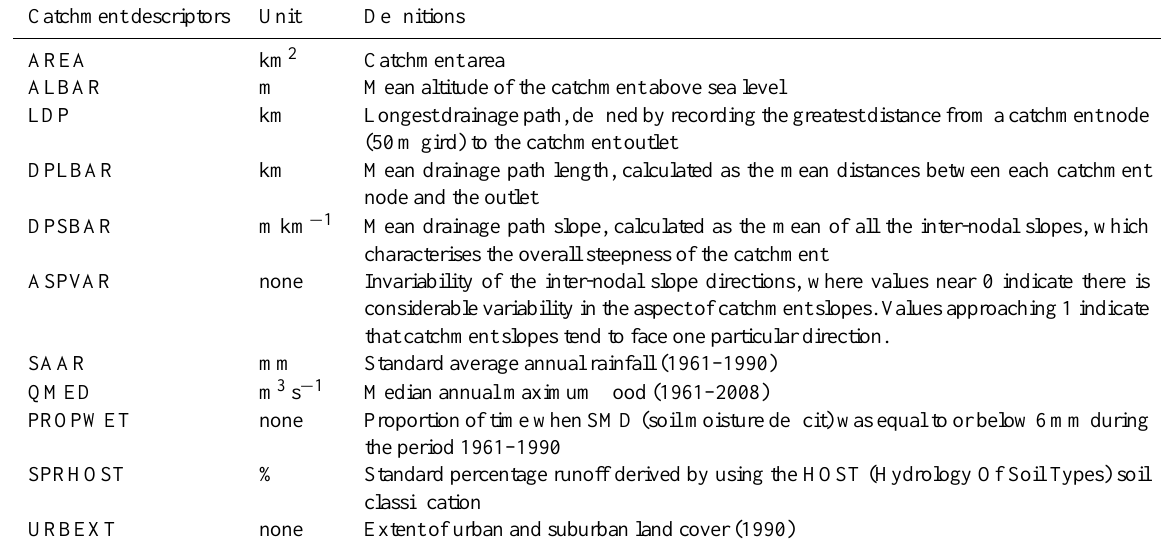
Table 3. Definitions of the FEH catchment descriptors (Bayliss,